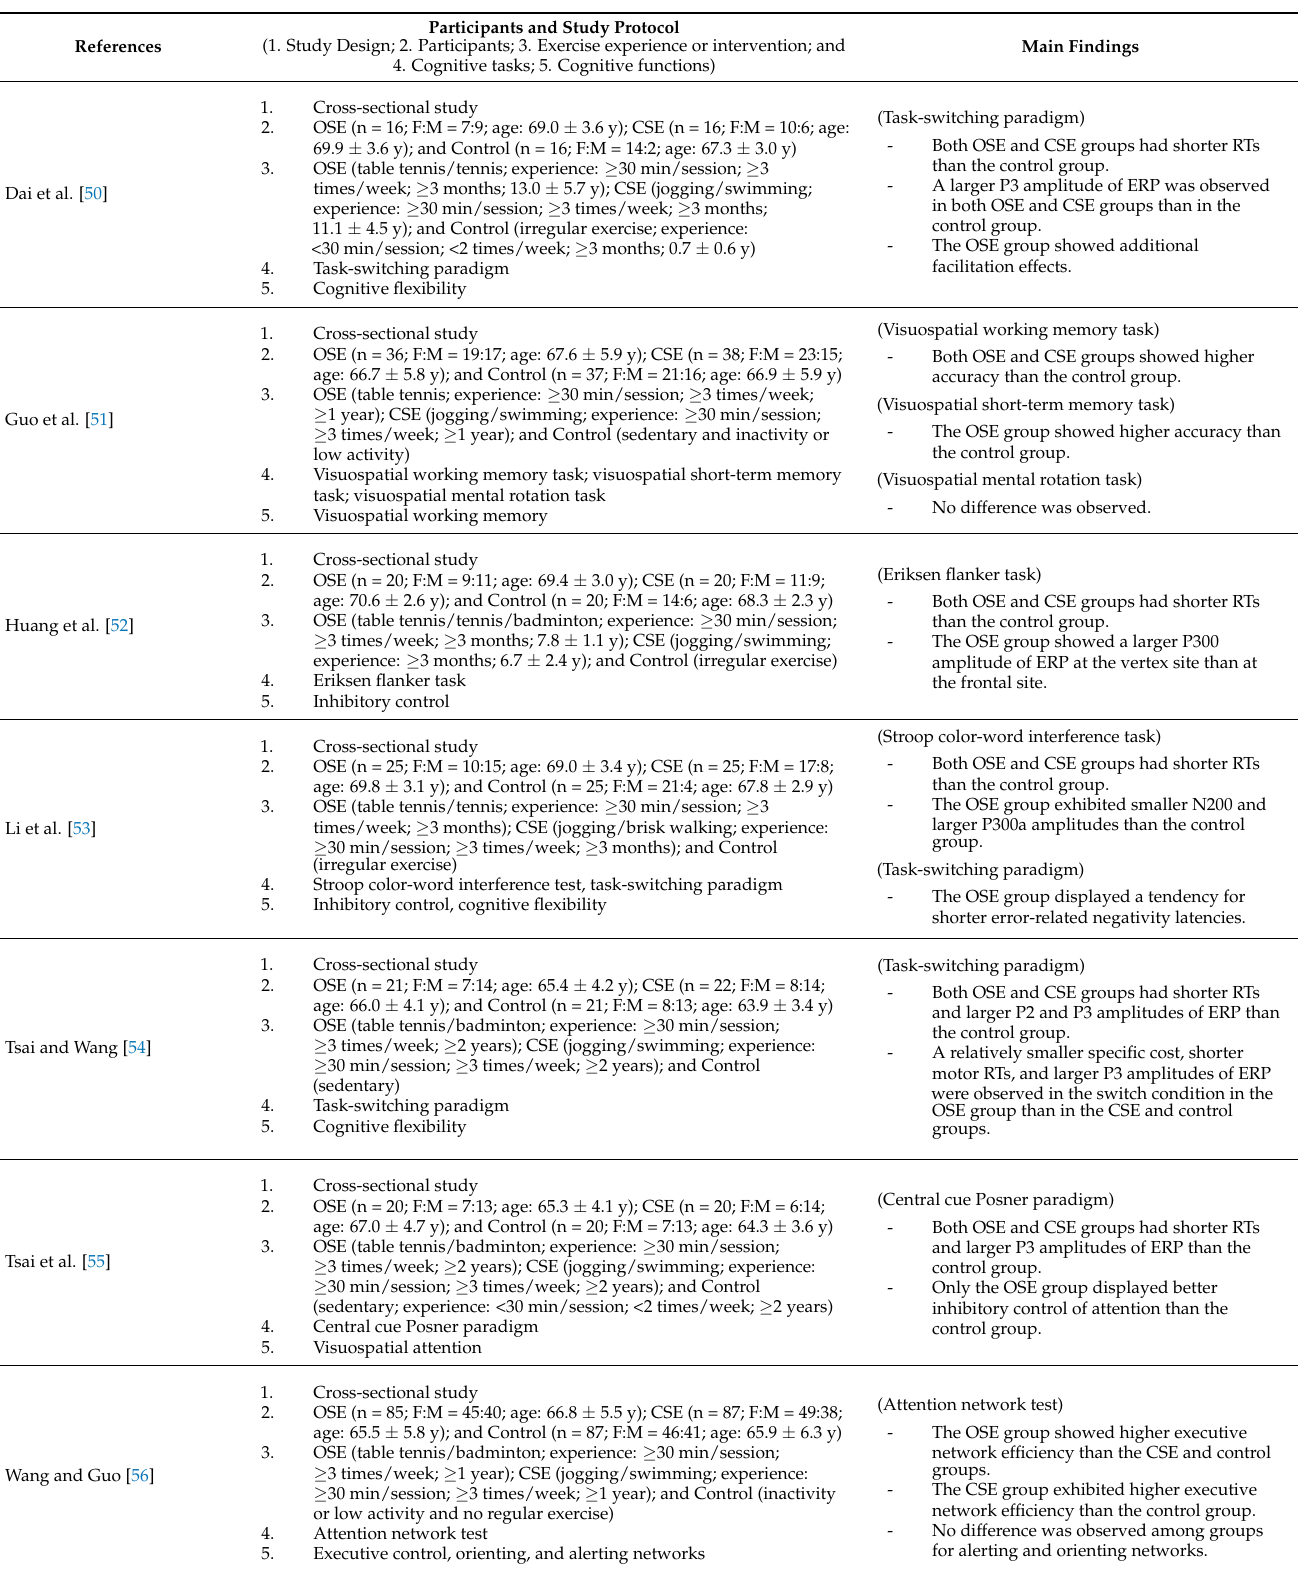
Table 5. Characteristics of studies comparing the effects of OSE and CSE on cognitive function in the